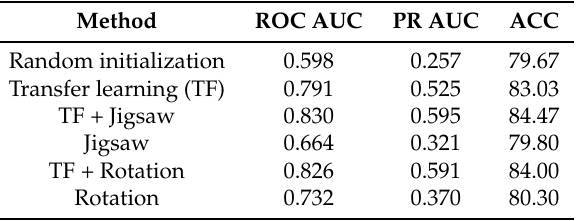
Table 1. Results of using self-supervised learning.